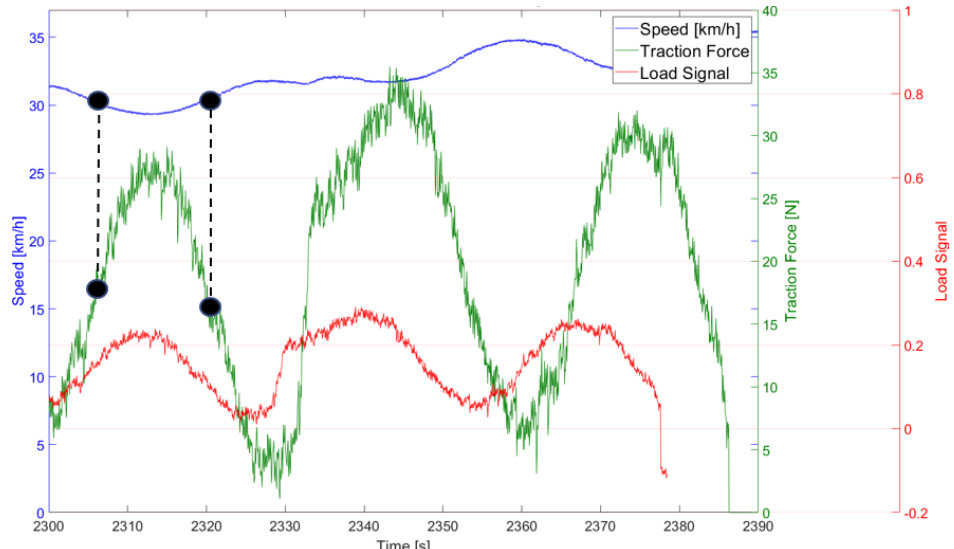
Figure 4. Example for manual cornering resistance evaluation.